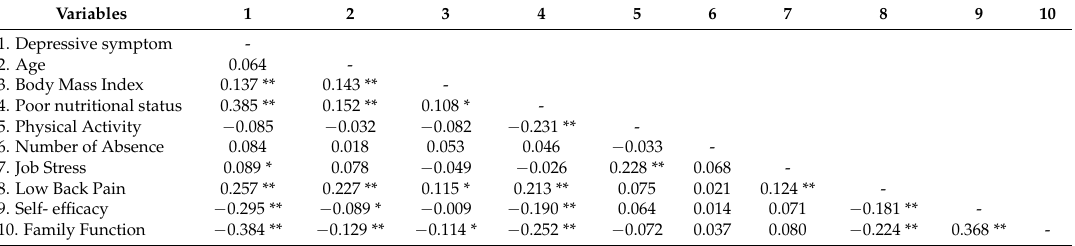
Table 2. Correlations among independent variables and depressive symptom ( N = 500).